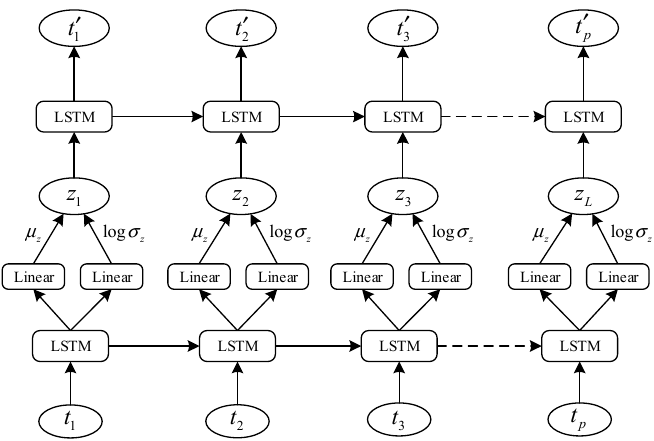
Figure 4. The expansion form of the LSTM–VAE encoder and decoder in the time domain.